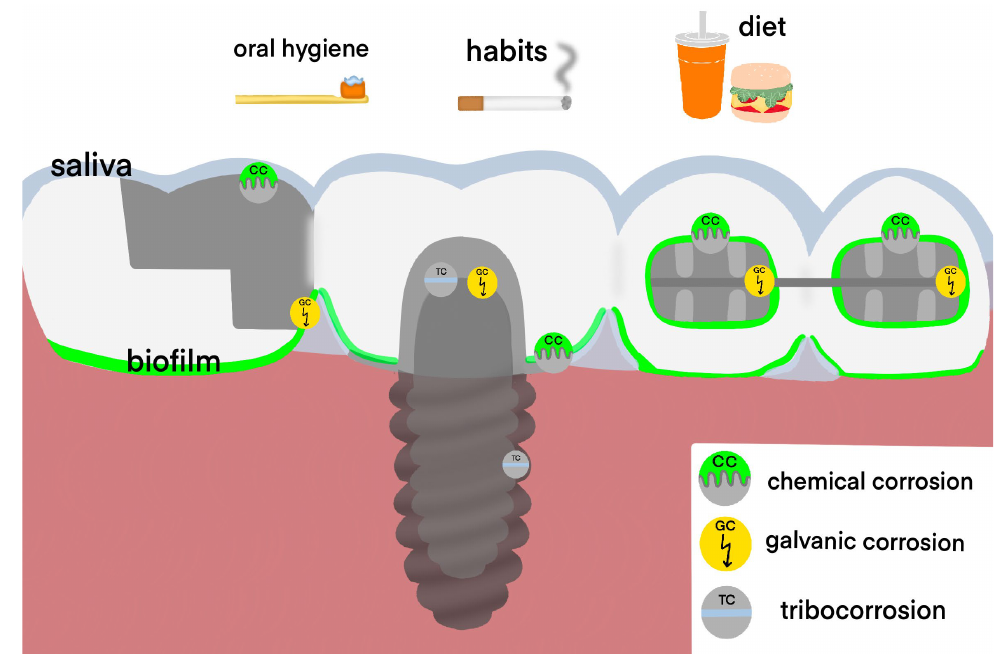
Figure 1. Interactions of dental alloys with the oral environment. The dental alloys are affected by intraoral (saliva, oral biofilm) and extraoral (food, drinks, oral hygiene, etc.) factors, which lead to chemical corrosion. Moreover, metallic appliances produced from different dental alloys in the oral environment may have galvanic interaction. In addition to that, the components of dental implants form a tribosystem where corrosion and wear are